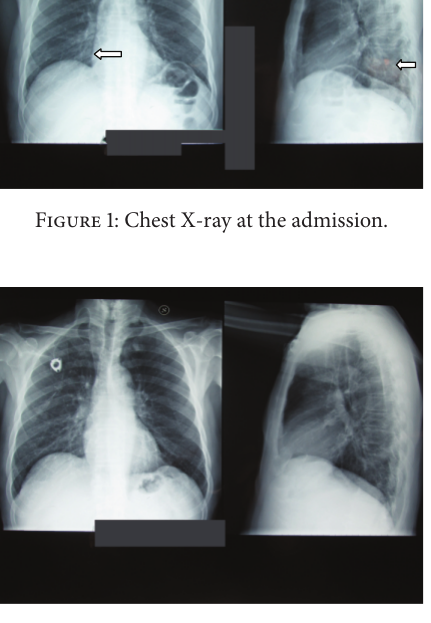
Figure 2: Chest X-ray after lipid formulation of amphotericin B